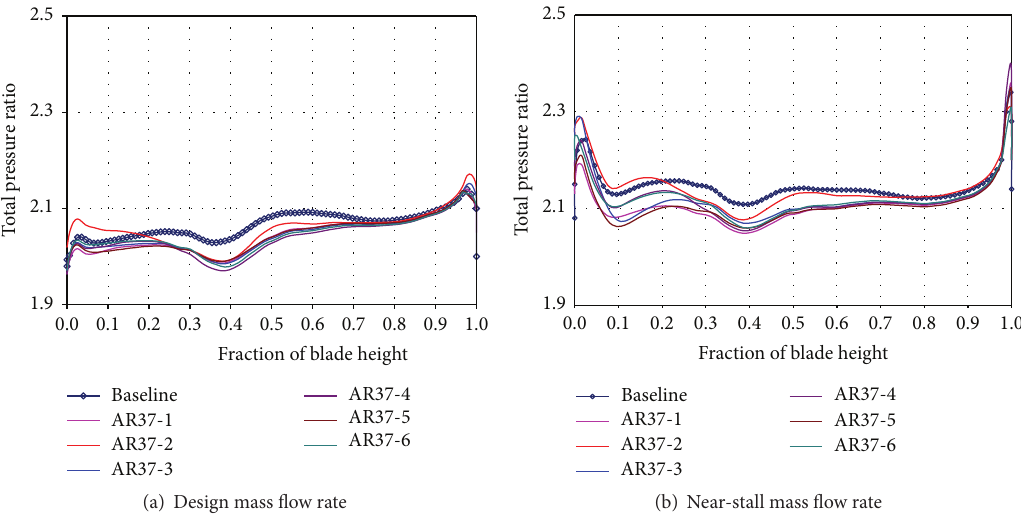
Figure 14: Radial variation of total pressure ratio across the rotor for different aspiration slot configurations (100% design rotational speed).